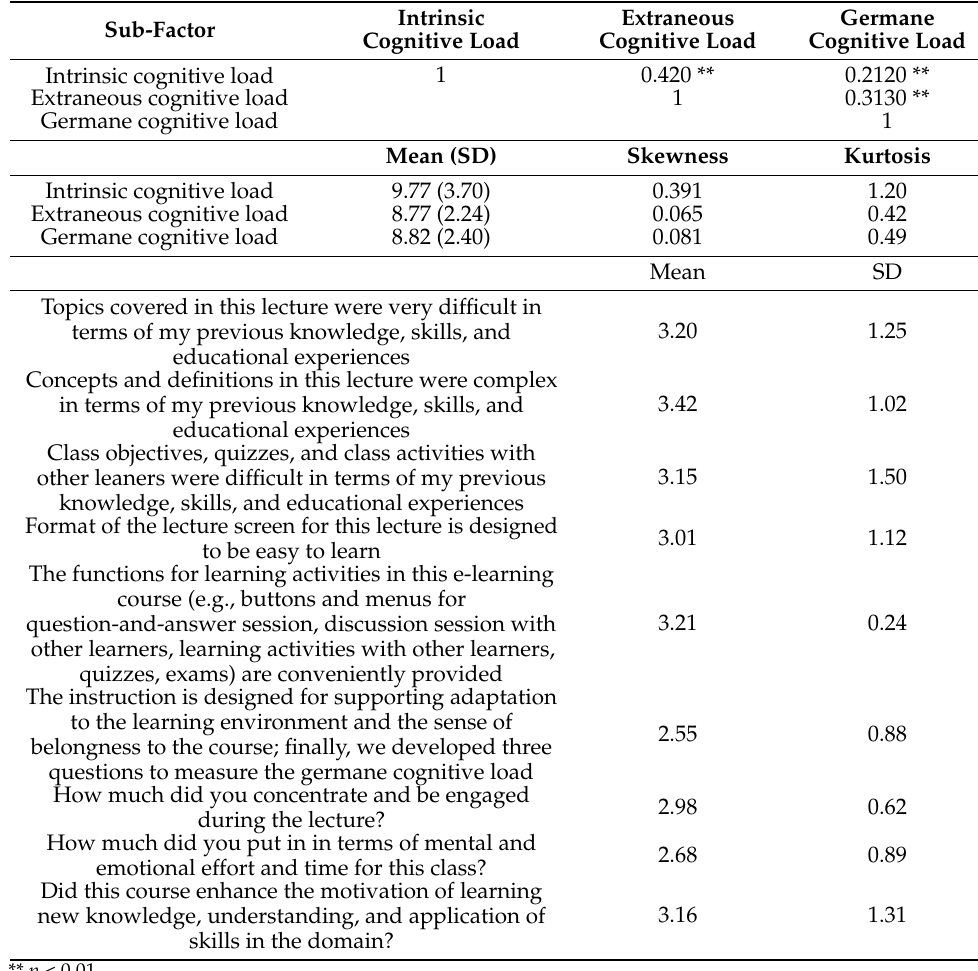
Table 2. Descriptive statistics of three cognitive load